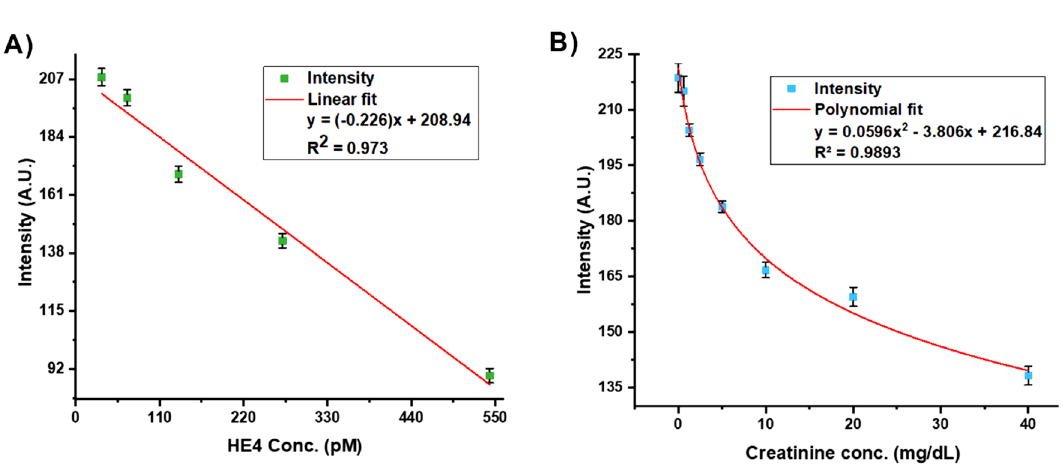
Figure 5. HE4 test line intensity as a function of the assay read time (mean + s.d., n = 2) (left panel). The color intensity as a function of assay read time for three creatinine concentrations of 5 mg/dL, 20 mg/dL, and 40 mg/ dL (mean + s.d, n = 3) (right panel).